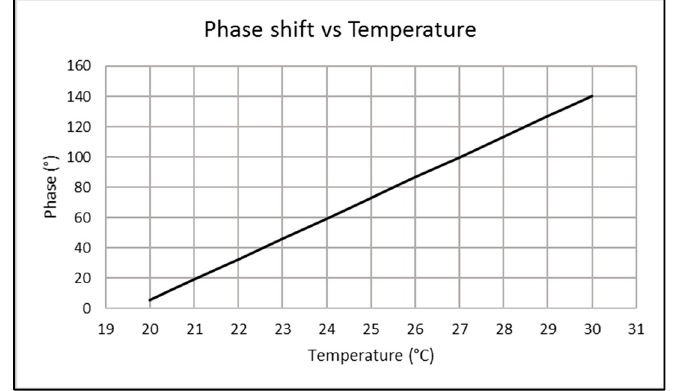
Figure 5. Phase-shift vs. temperature for 15mm steel.